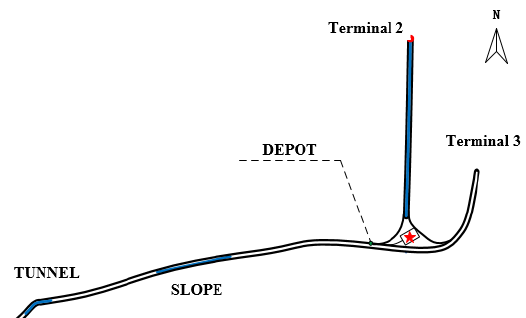
Figure 5. Beijing capital airport line route map.